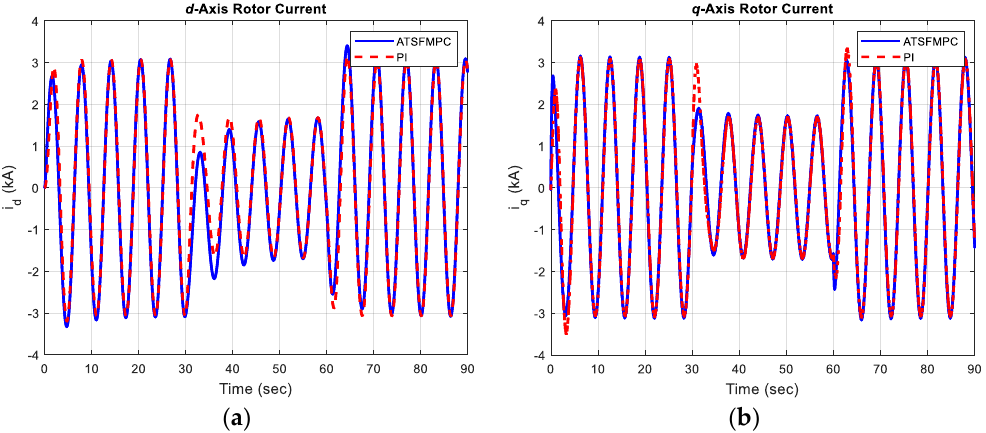
Figure 6. Response of d -axis and q -axis rotor currents for proportional-integral (PI) and ATSFMPC for Northwest European shelf.